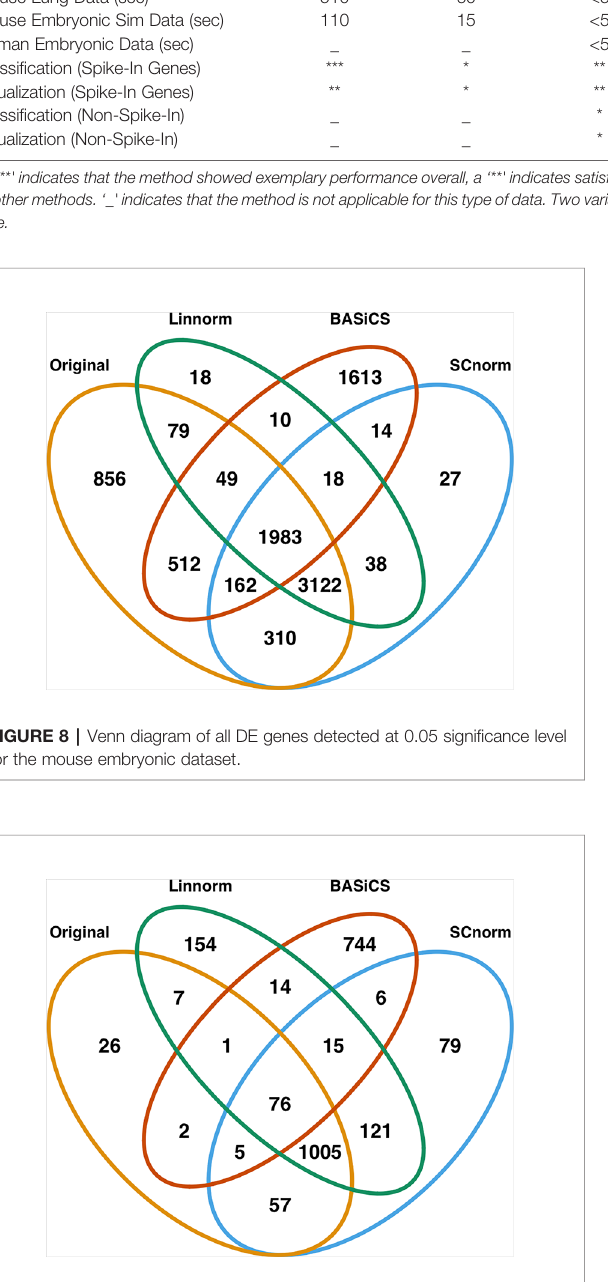
FIGURE 9 | Venn diagram of all DE genes detected at 0.05 signi fi cance level for the mouse lung data set.